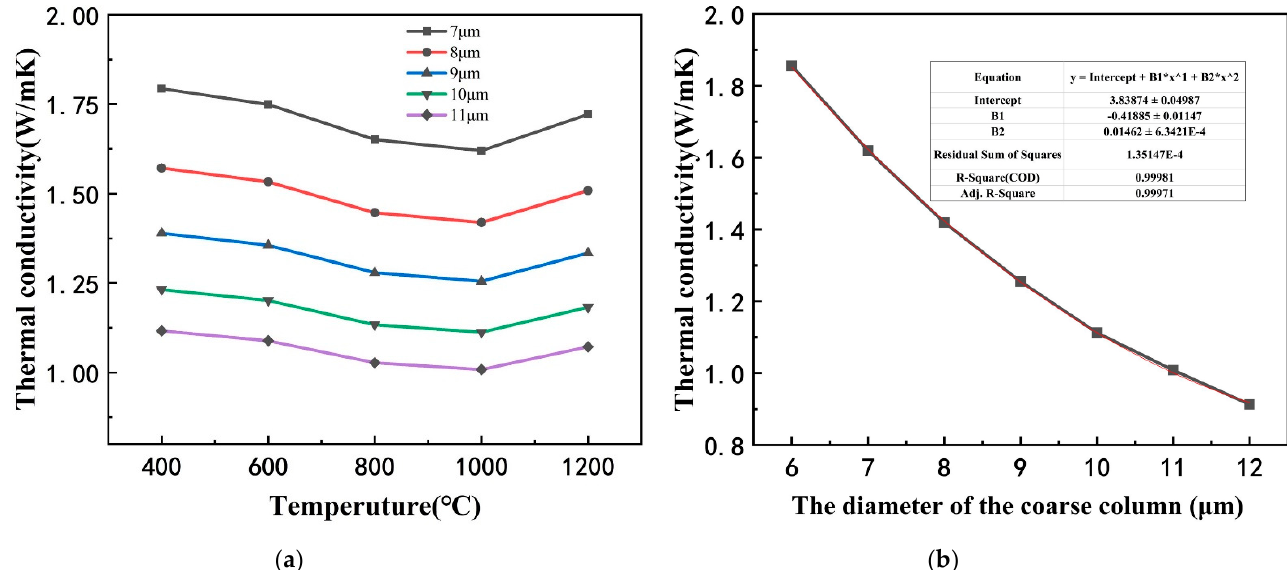
Figure 7. Effective thermal conductivity of models with different coarse column diameter of the coating: ( a ) at different levels of temperature, ( b ) at 1000 °C